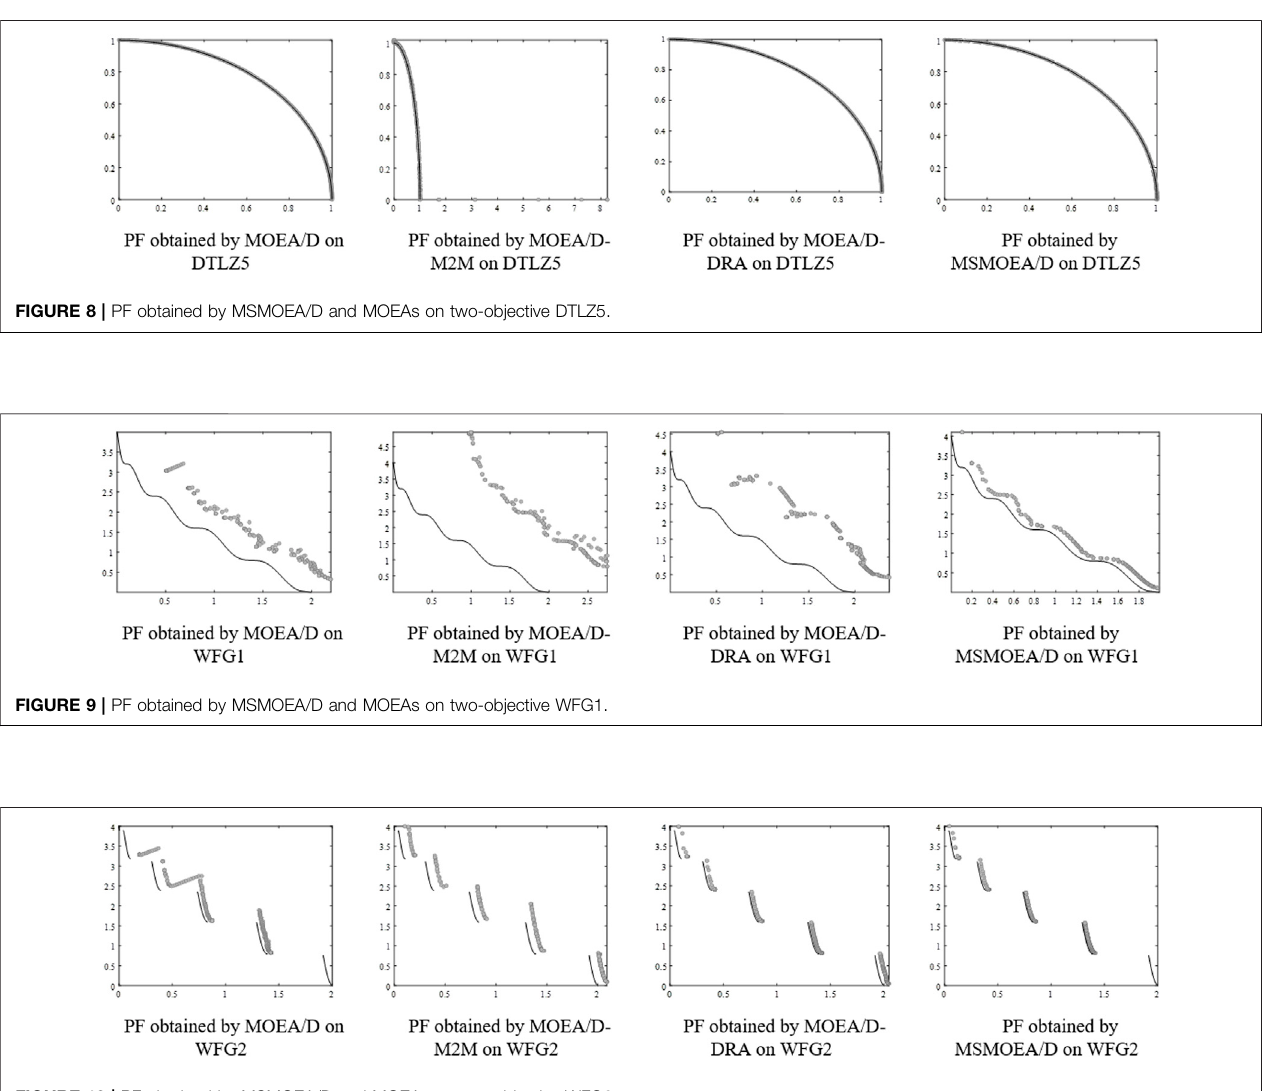
FIGURE 10 | PF obtained by MSMOEA/D and MOEAs on two-objective WFG2.